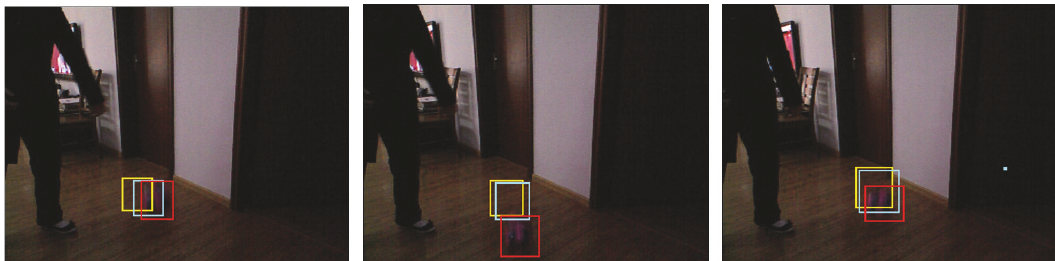
Figure 4: The comparison results on zballpat no1 video from PTB